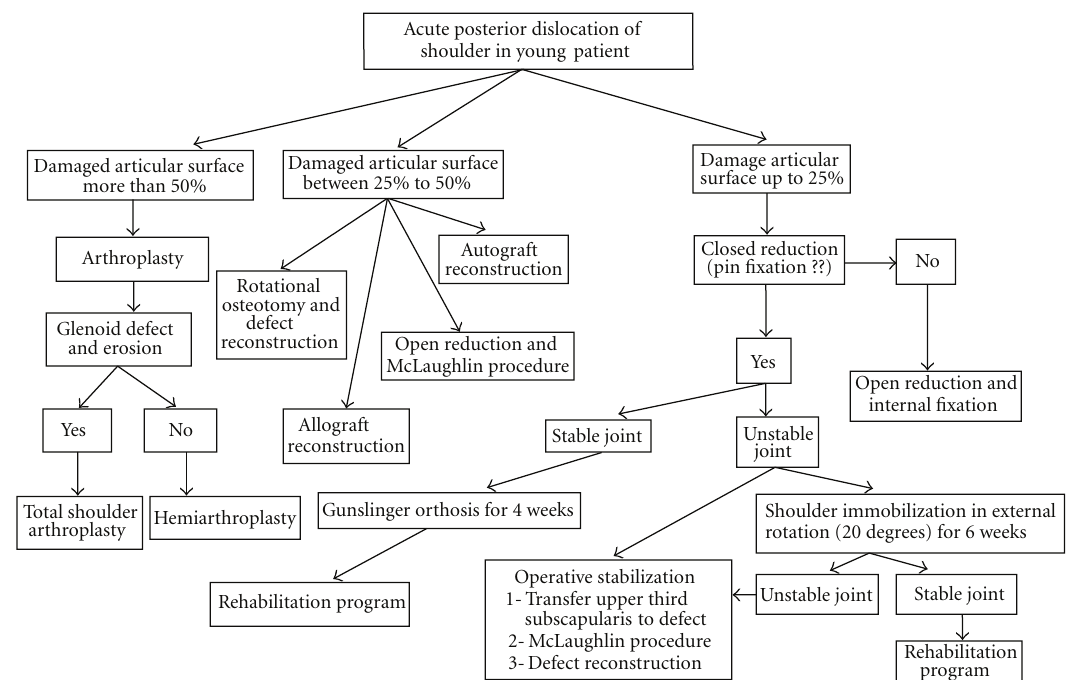
Figure 4: Algorithm of management of acute posterior shoulder dislocation in young